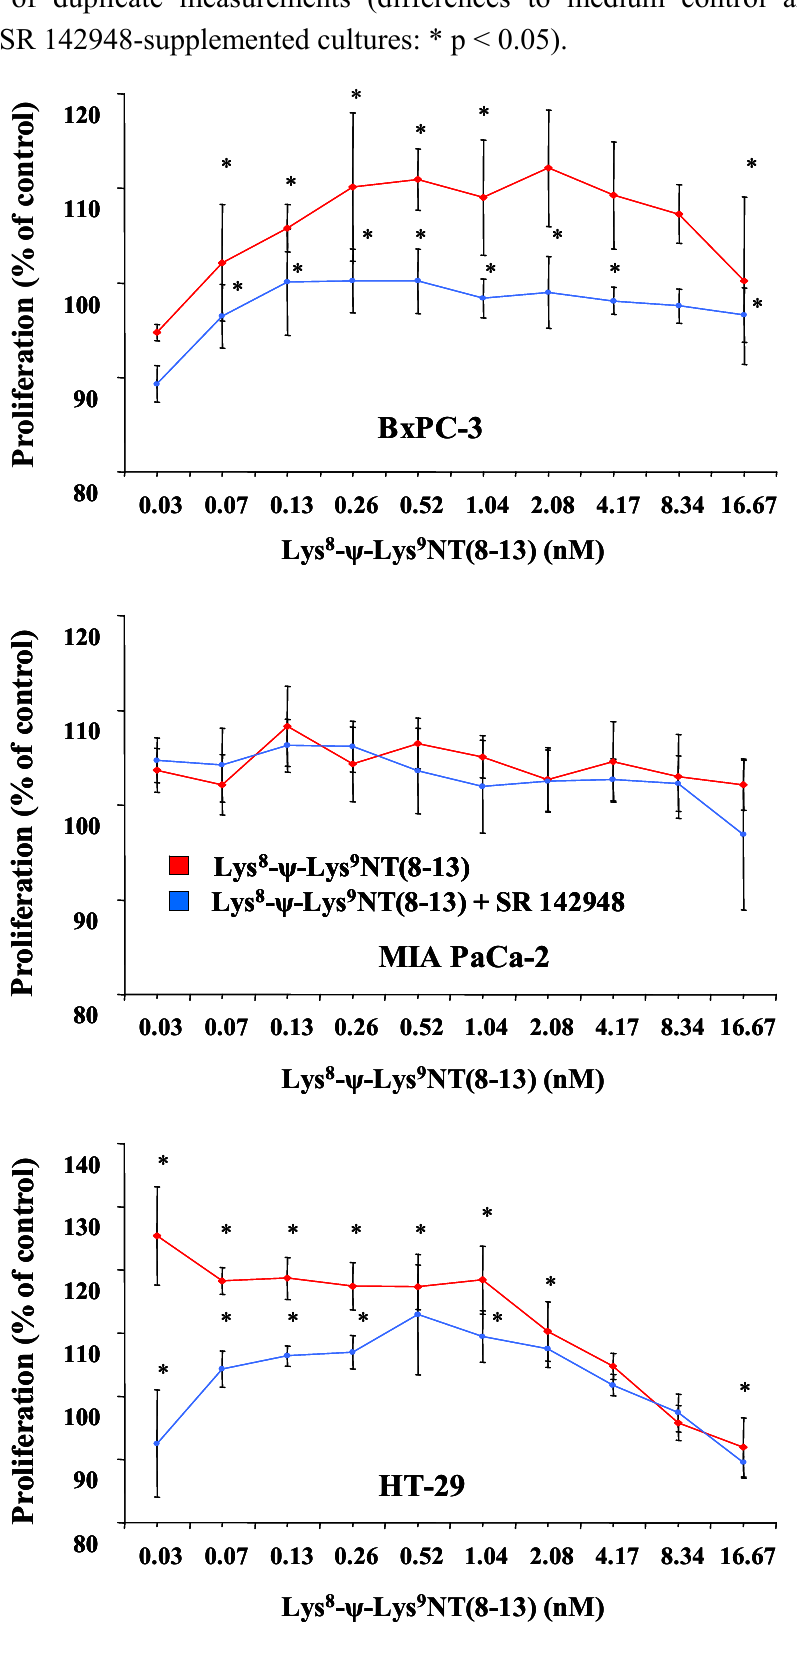
Figure 1. Proliferative responses of BxPC-3 (top), MIA PaCa-2 (middle) and HT-29 (bottom) cells to Lys 8 - ψ -Lys 9 NT(8–13) alone or in combination with 20 µM SR 142948 obtained by MTT proliferation assays after seven days of incubation. Data are presented as mean ± SD of duplicate measurements (differences to medium control and between NT- and NT/SR 142948-supplemented cultures: * p <